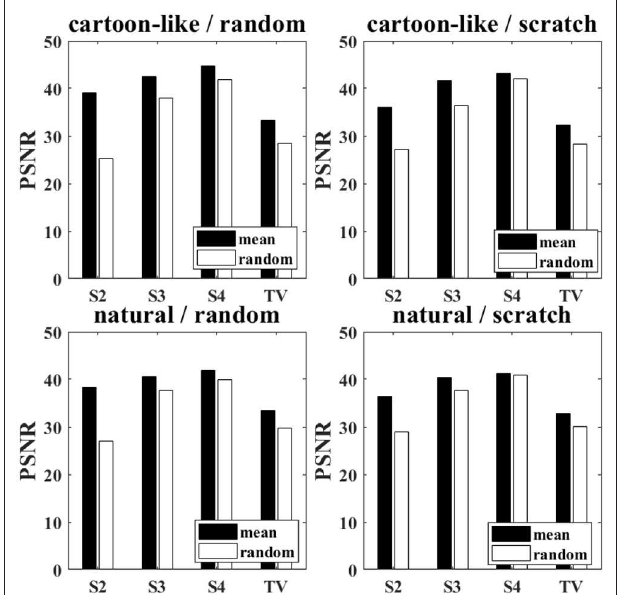
FIGURE 4 | Obtained PSNR values using random starting guess (white) or mean value (black). (Left): random inpainting area (3% of the pixels); (Right): scratches (3 scratches, 4 pixels width); top: cartoon-like images; bottom: natural images.